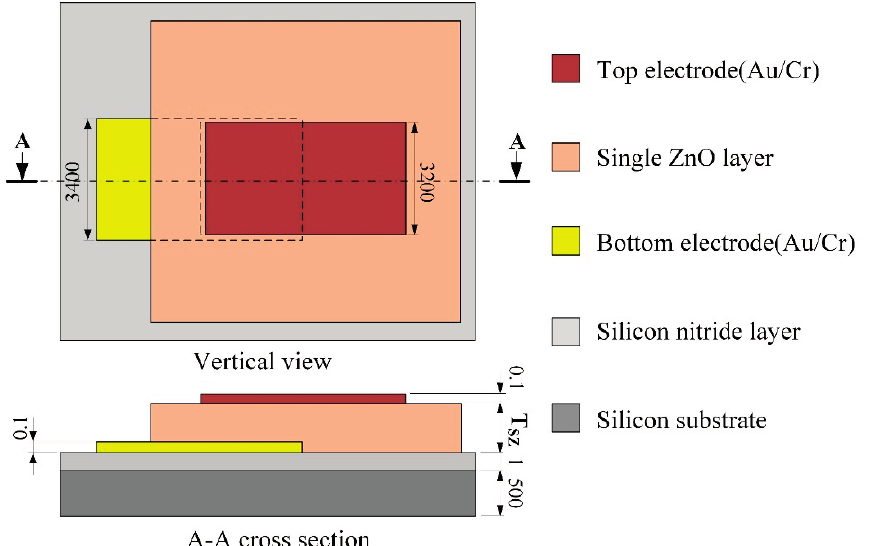
Figure 1. Schematic diagram of a general pyroelectric sensor with a single pyroelectric layer (unit: μ